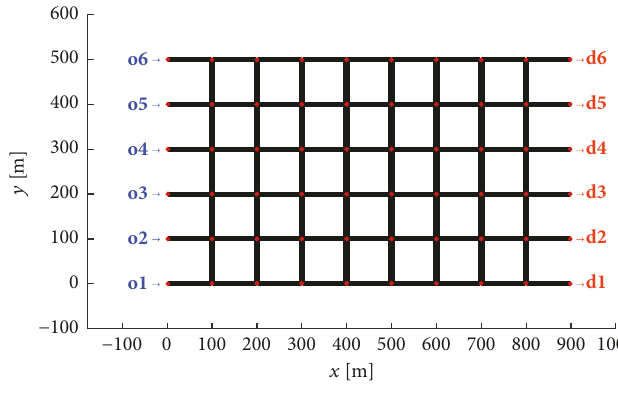
Figure 3: Manhattan